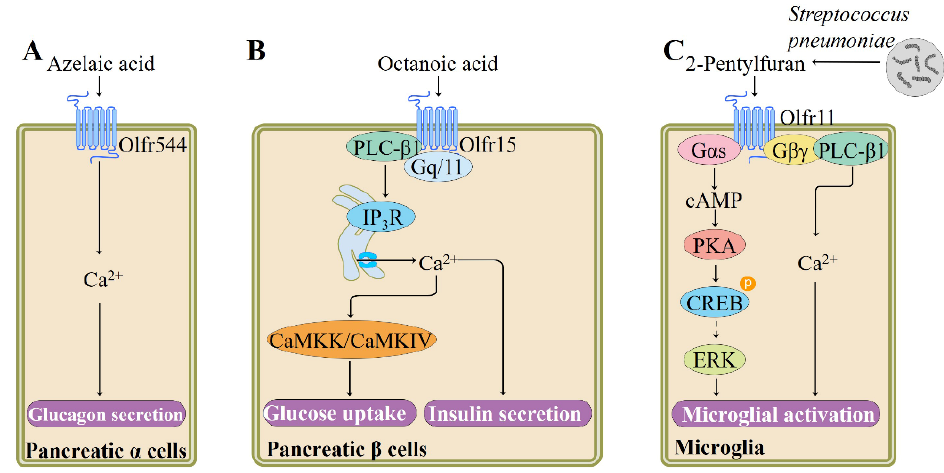
Figure 5. Summary of signaling pathways and functions regulated by ectopic ORs in pancreatic α and β cells and microglia. ( A ) Activation of olfr544 increases the secretion of glucagon from α cells, adapted from [10], published by Elsevier, 2015. ( B ) Stimulation of olfr15 enhances insulin secretion from β cells and glucose uptake, adapted from [99], published by Bentham Science Publishers, 2020. ( C ) Regulation of microglial activation by Streptococcus pneumoniae -secreted metabolite acting through olfr110, adapted from [100], published by Elsevier, 2020. cAMP, cyclic adenosine monophosphate; CaMKIV, Ca 2+ /calmodulin-dependent protein kinase IV; CaMKK, Ca 2+ /calmodulin-dependent protein kinase kinase; CREB, cAMP-responsive element-binding protein; ERK, extracellular signal- regulated kinase; IP 3 R, inositol-1,4,5-trisphosphate (IP 3 ) receptor; PLC, Gq-phospholipase C.